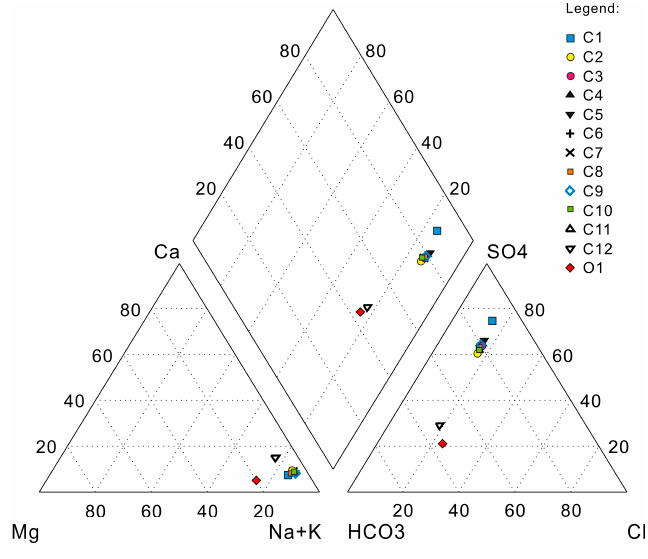
Figure 6. Piper diagram of hydrochemical types evolution in Carboniferous Taiyuan limestone karst-fissure aquifer systems.